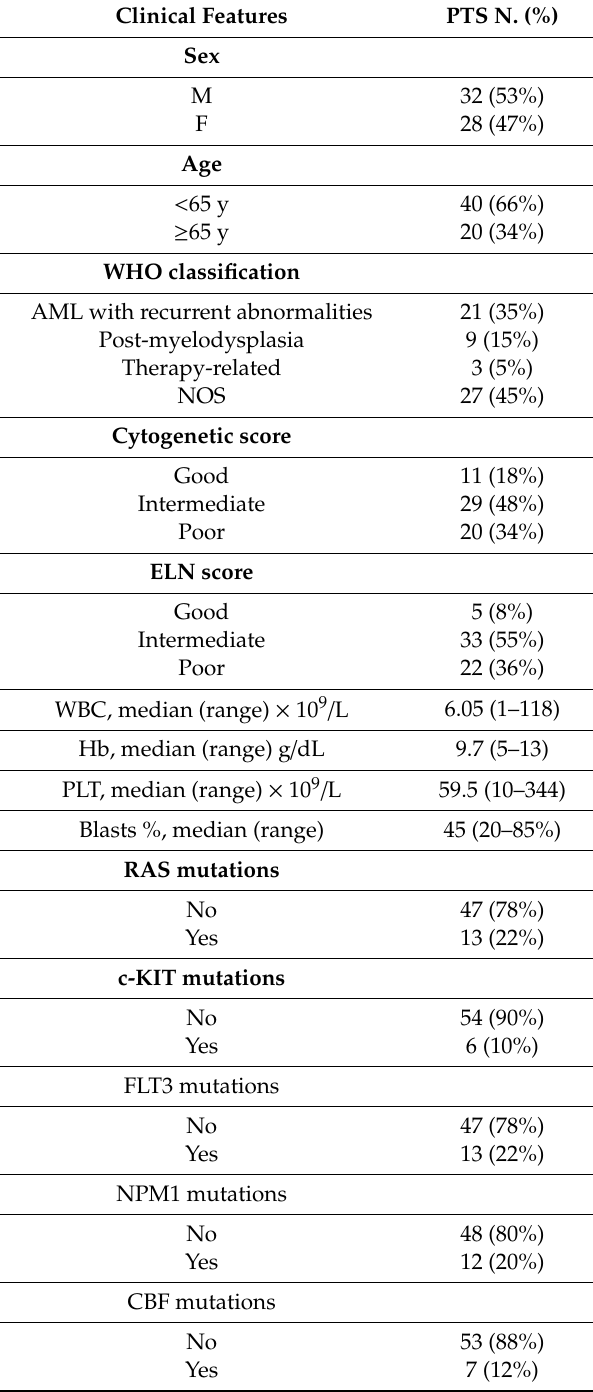
Table 5. Clinical features of 60 patients enrolled in the